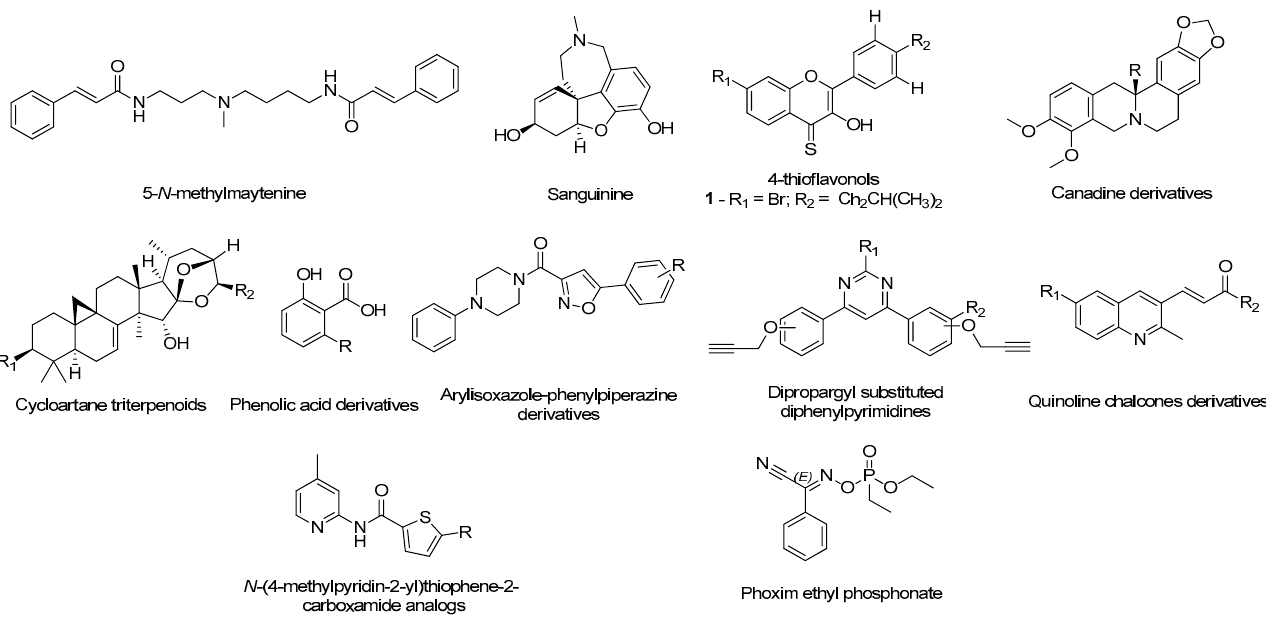
Figure 2. Structures of the studied AChE inhibitors.